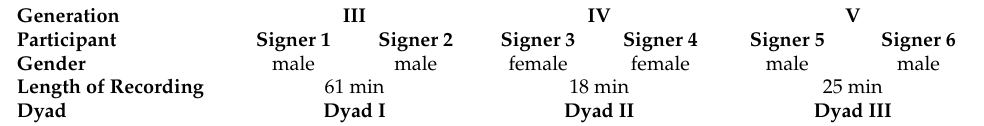
Table 1. Detailed information on the sample used in the present